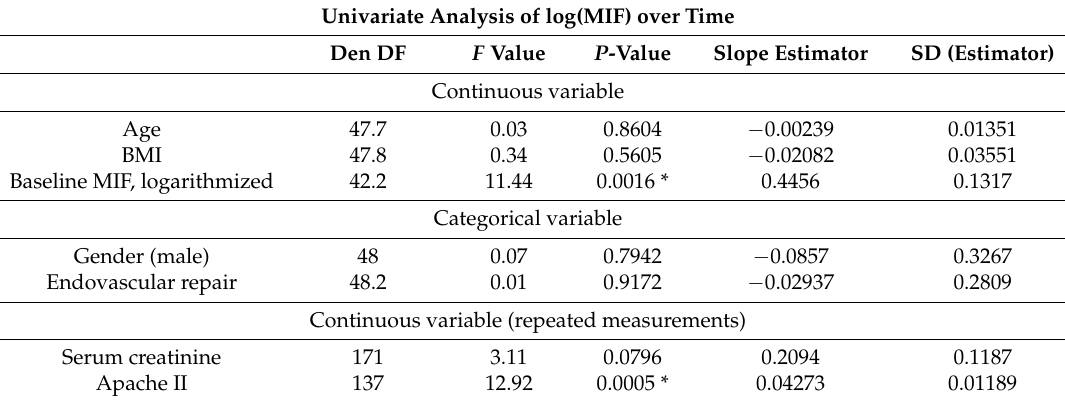
Table 2. Univariate analysis of continuous and categorical variables correlating with MIF.